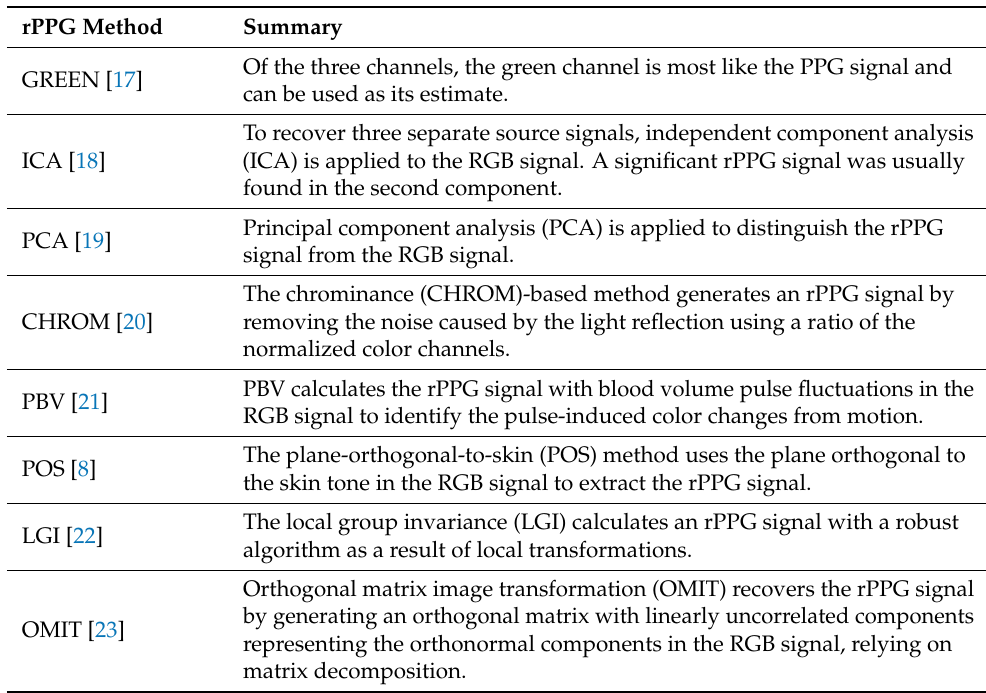
Table 1. Summary of the rPPG